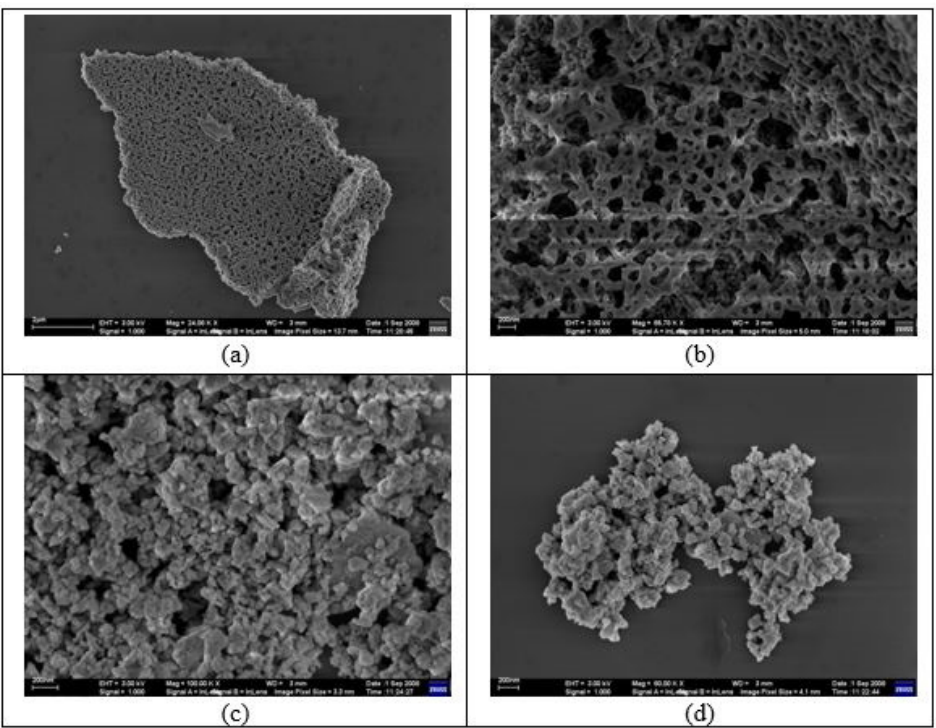
Figure 4. Micrographs of powder precursor before (a, b) and after (c, d) milling with Zirconium sphere.